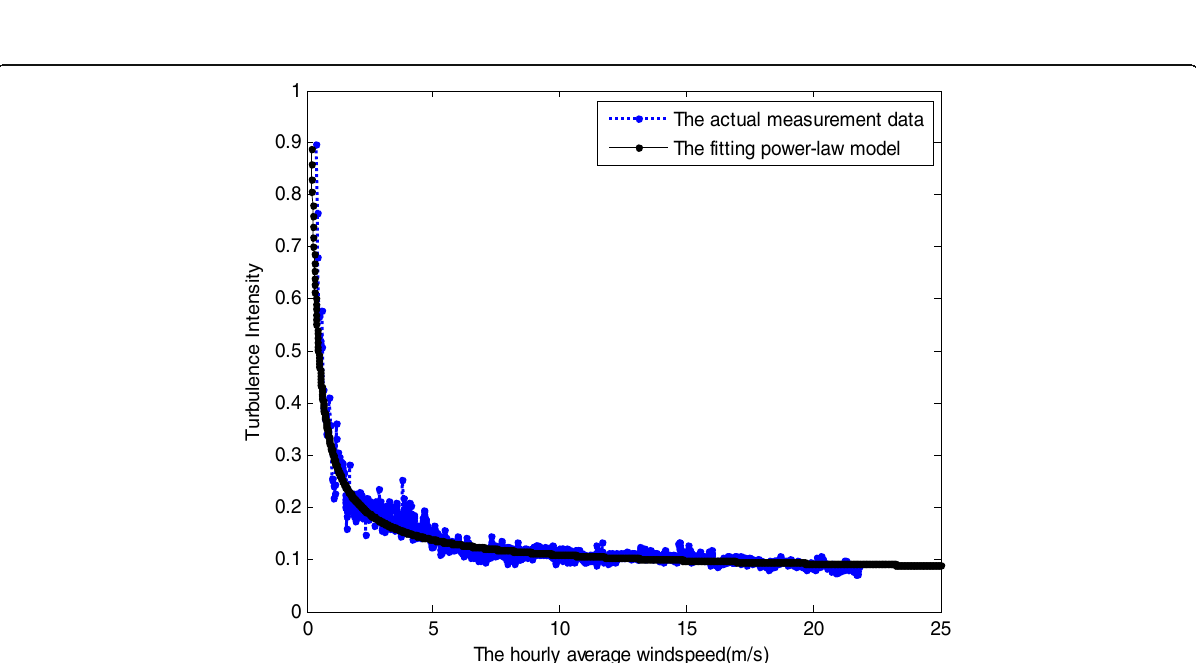
Fig. 8 Relationship between wind speed ’ s average value and its corresponding fluctuation